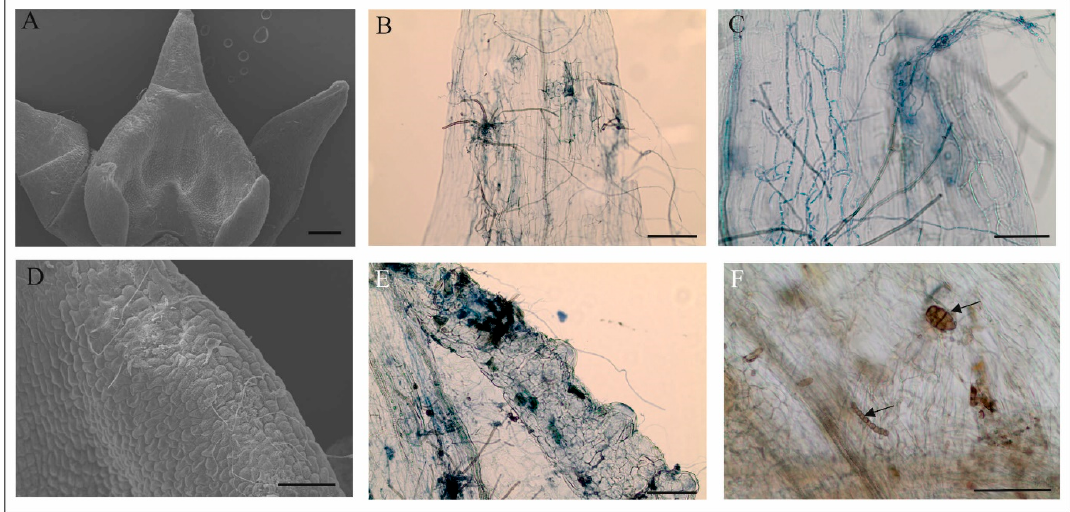
Figure 7. M. monophyllos labellum with a wide range of fungi both on the surface and inside tissues. ( A – F ) Both fungal hyphae and spores ( F , arrow) are visible. Scale bars: 200, 20, 50, 50, 50, 50 µm.